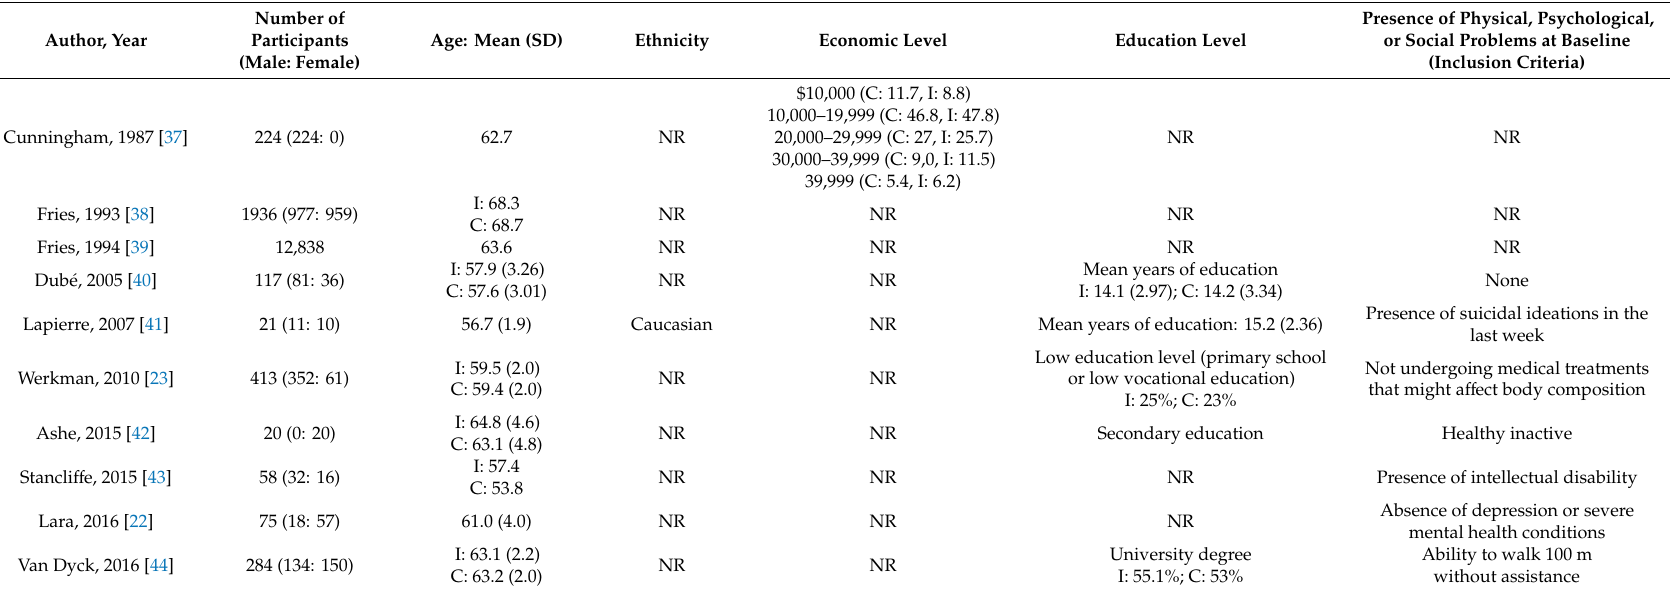
Table 1. Details of participants in the experimental